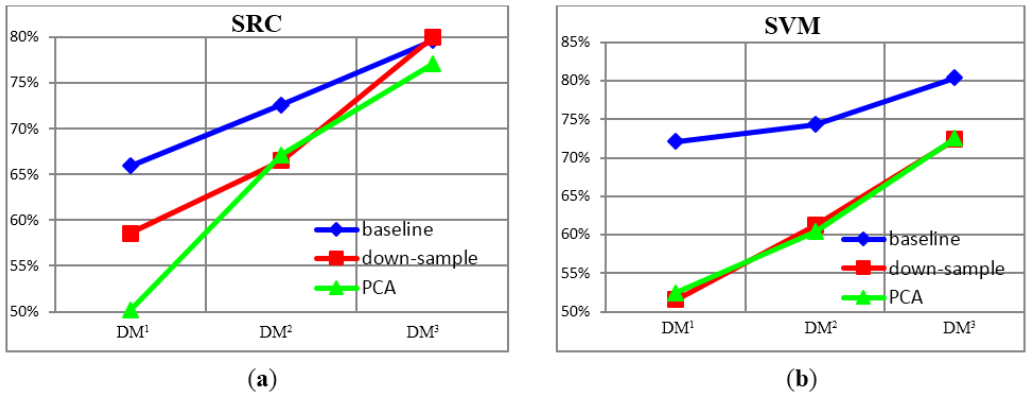
Figure 4. The recognition accuracy of the two classifiers under different feature spaces; ( a ) and ( b ) refer to the recognition accuracy achieved by SRC and SVM, respectively. DM 1 , DM 2 and DM 3 stand for the dimensions of feature spaces adopted here that have sizes of 16, 36 and 81, respectively.